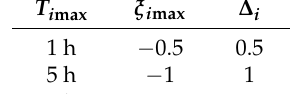
Figure 6. ( a ) The outdoor temperature curve of the day and ( b ) Six parameter clusters of 5000 ACLs.